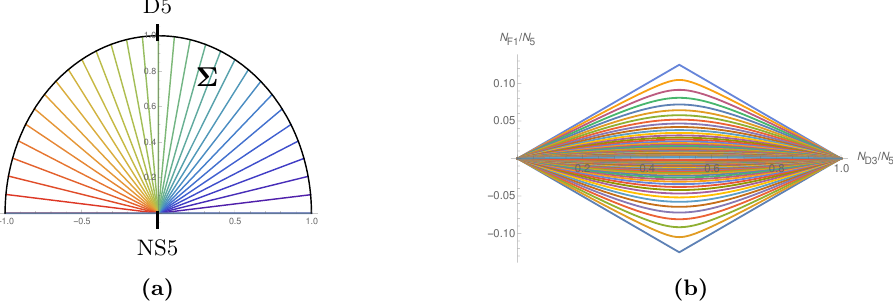
Figure 6. Left: Σ as half disc in the u coordinate defined in (4.41), with D5 0 Wilson loop embeddings. For concreteness, NS5/D5 poles are shown at u = 0 / u = i , corresponding to the D5/NS5 theory. Right: space of (D3 , F1) charges carved out by the D5 0 embeddings for the D5/NS5 theory. The curves vary d for fixed F el . From top to center the curves correspond to F el increasing from 0 to ∞ . The bottom half of the curves corresponds, from bottom to center, to F el decreasing from 0 to −∞ . The shape reproduces the shape of the quiver